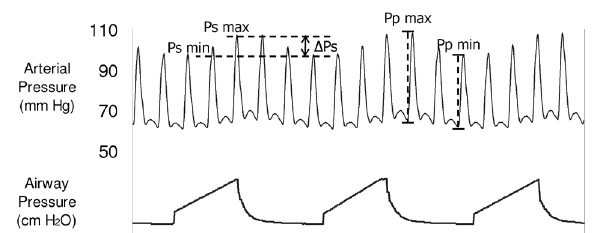
Figure 1 - The representative trace shows the arterial pressure fluctuations during mechanical ventilation. The systolic pressure is maximal during inspiration and declines in expiration. Similarly, arterial pulse pressure is maximal during inspiration and minimal during expiration. Pp arterial pulse pressure; Pp , minimal arterial pulse pressure; Ps min arterial systolic pressure; Ps , minimal arterial systolic min